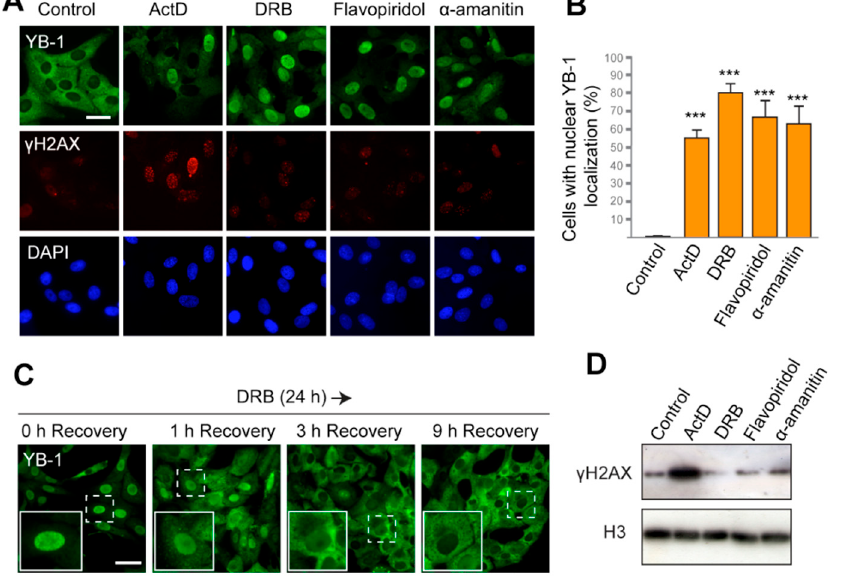
Figure 1. The Y-box binding protein 1 (YB-1) accumulates in the nucleus in response to inhibition of transcription. ( A ) Localization of YB-1 in Vero cells treated with DMSO (control), actinomycin D (ActD), 5,6-dichlorobenzimidazole 1- β -D-ribofuranoside(DRB), flavopiridol, and α -amanitin for 24 h. Scale bar 50 µ m. ( B ) Quantification of cells with predominant nuclear localization of YB-1 (signal in the nucleus is higher than that in the cytoplasm) after 24 h treatment with ActD, DRB, flavopiridol, or α -amanitin. Results are mean ± SD. *** p < 0.001, paired t -test; n = 50 for each condition in three independent experiments. Examples of images used for quantification are shown in Figure S1A. ( C ) Localization of YB-1 in Vero cells after treatment with DRB for 24 h, followed by withdrawal of the drug (1, 3, and 9 h time points of recovery are indicated). Scale bar 50 µ m. ( D ) Western blot for histone γ H2AX and histone H3 of the whole-cell extract from Vero cells treated with ActD, DRB, flavopiridol, and α -amanitin for 24 h.